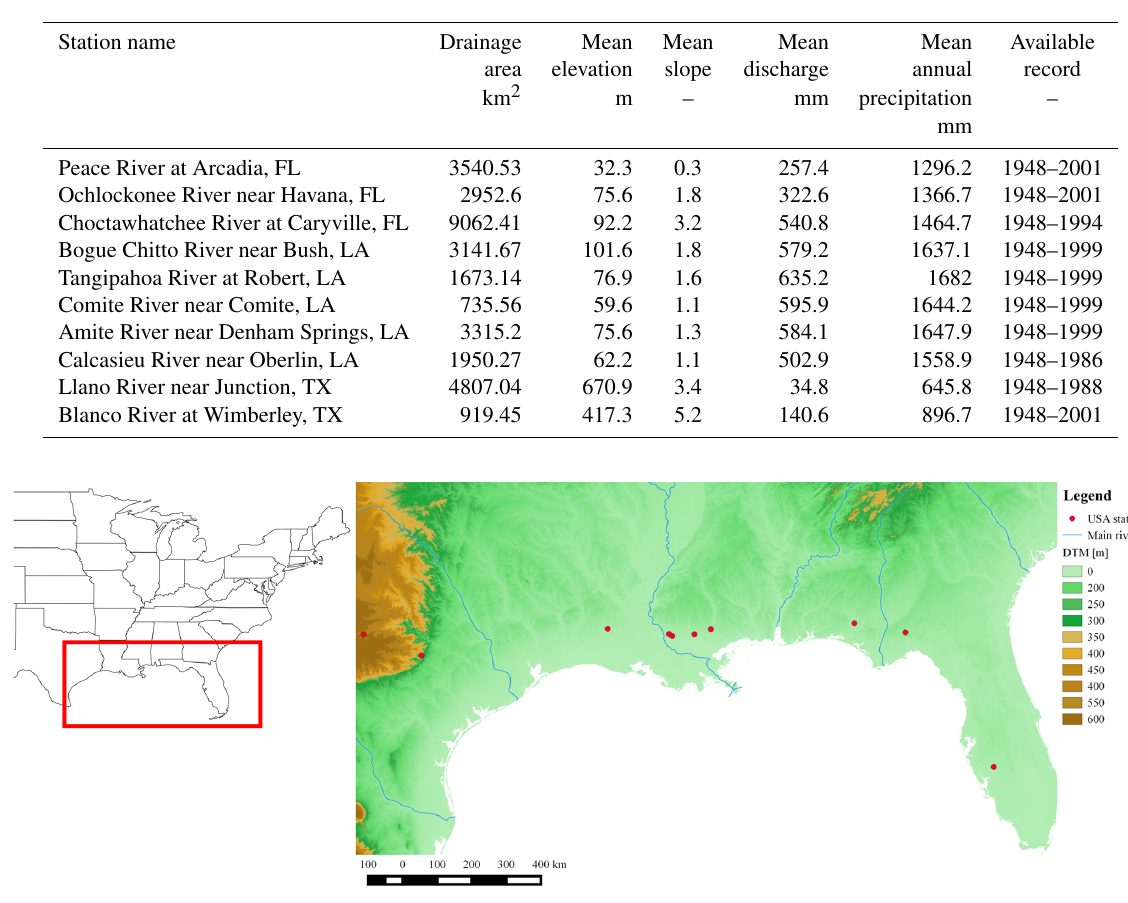
Figure 1. Streamflow gauges (red circles) used to test the methodology in the corresponding US basins. DTM retrieved from Jarvis et al.